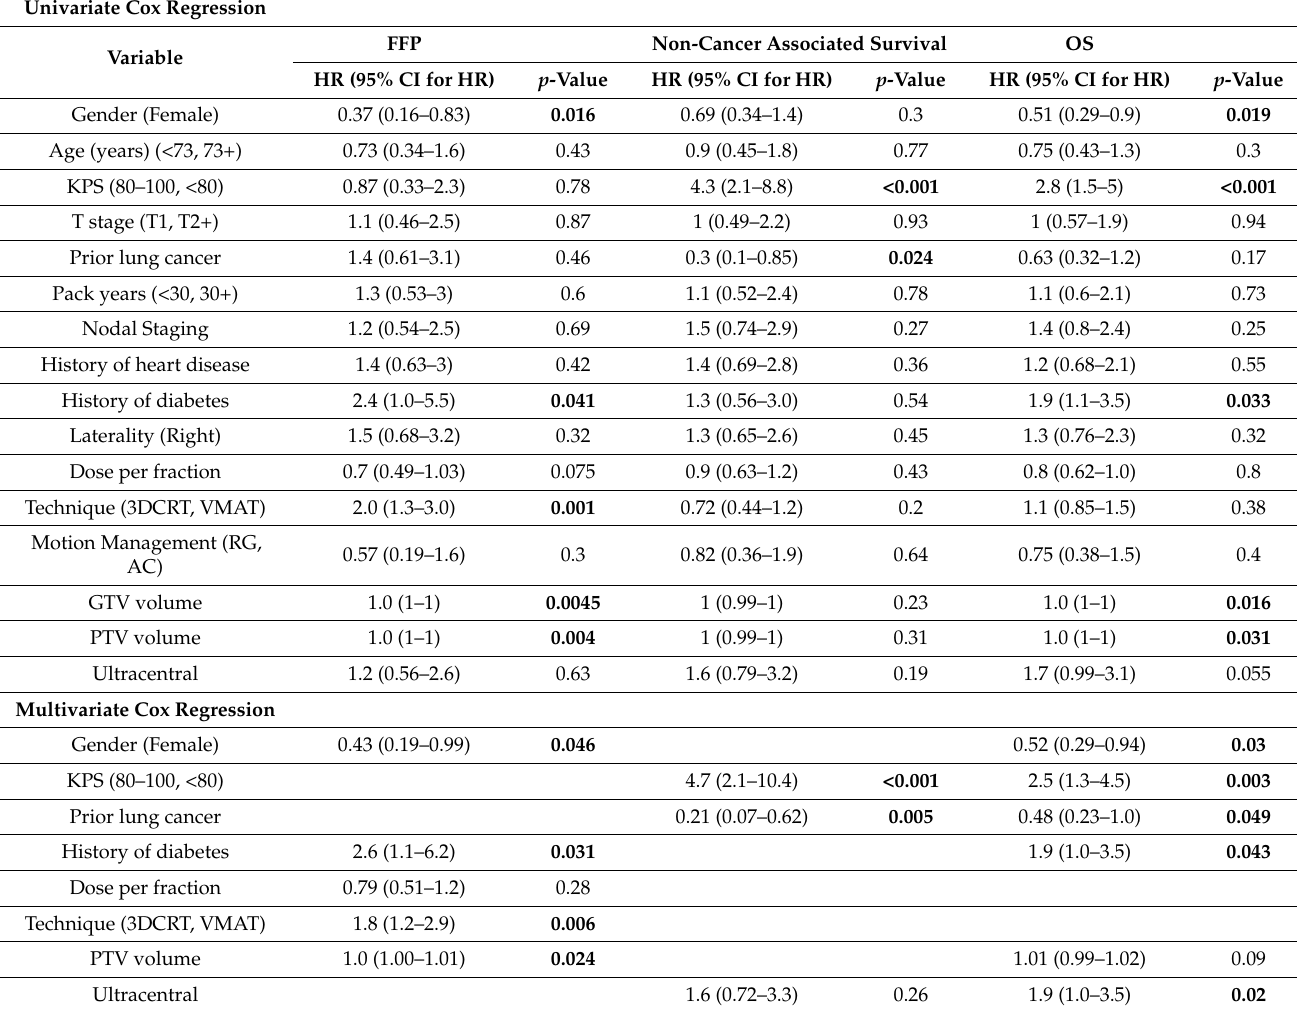
Table 2. Univariate and Multivariate Cox